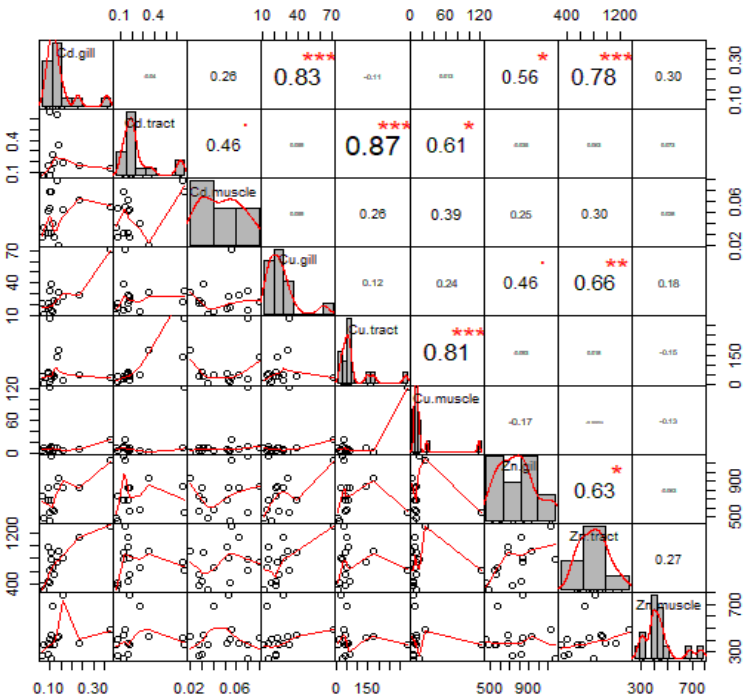
Fig. 6: Relationships between inter-metal levels (Cd, Cu, Zn) in various tissues (gill, digestive tract, muscle) in Subang site (***: significant at P < 0.05)